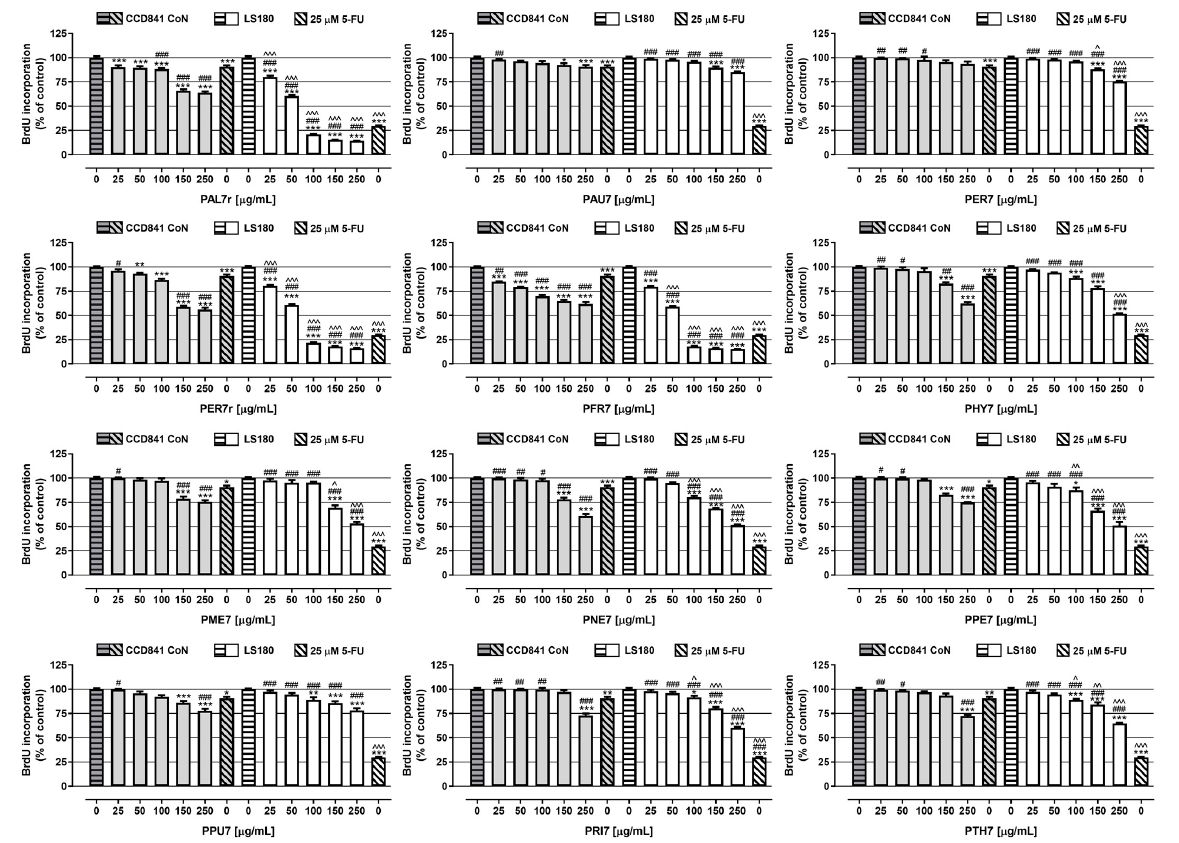
Figure 2. Antiproliferative effect of extracts on CCD841 CoN and LS180 cell lines. The cells were exposed for 48 h to the culture medium alone (control). extract at concentrations of 25–250 µg/mL. or 25 µM 5-fluorouracil (5-FU; positive control). The antiproliferative impact of investigated compounds was measured using BrdU assay (incorporation of BrdU to newly synthesised DNA). Results are presented as mean ± SEM of at least 4 measurements. * p < 0.05; ** p < 0.01; *** p < 0.001 vs. control. # p < 0.05; ## p < 0.01; ### p < 0.001 vs. positive control. ^ p < 0.05; ^^ p < 0.01; ^^^ p < 0.001 colon cancer cells treated with extract/5-FU vs. colon epithelial cells exposed to the extract/5-FU at the corresponded concentration; one-way ANOVA test; post-test: Tukey’s.